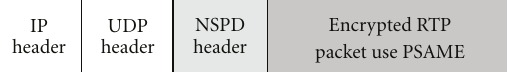
Figure 5: The protocol data unit in playback